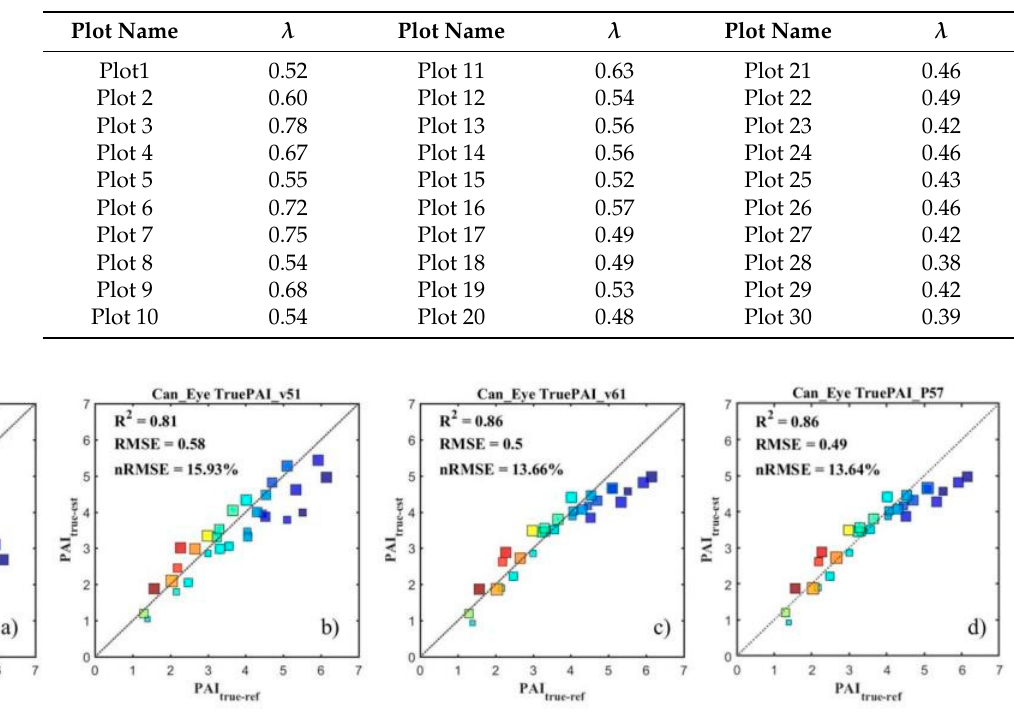
Table 5. Values of the clumping index ( λ ) for the 30 virtual forest plots.